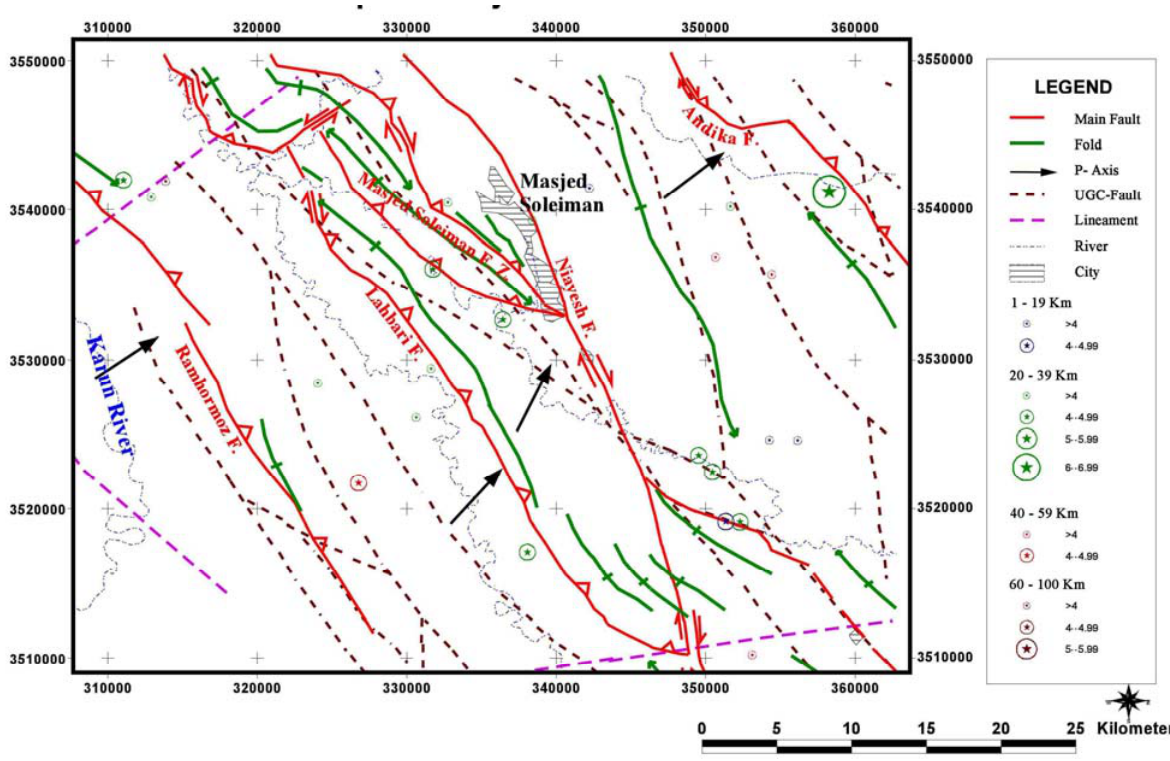
Figure 3. Seismotectonic map of the Masjed-i-Soleiman